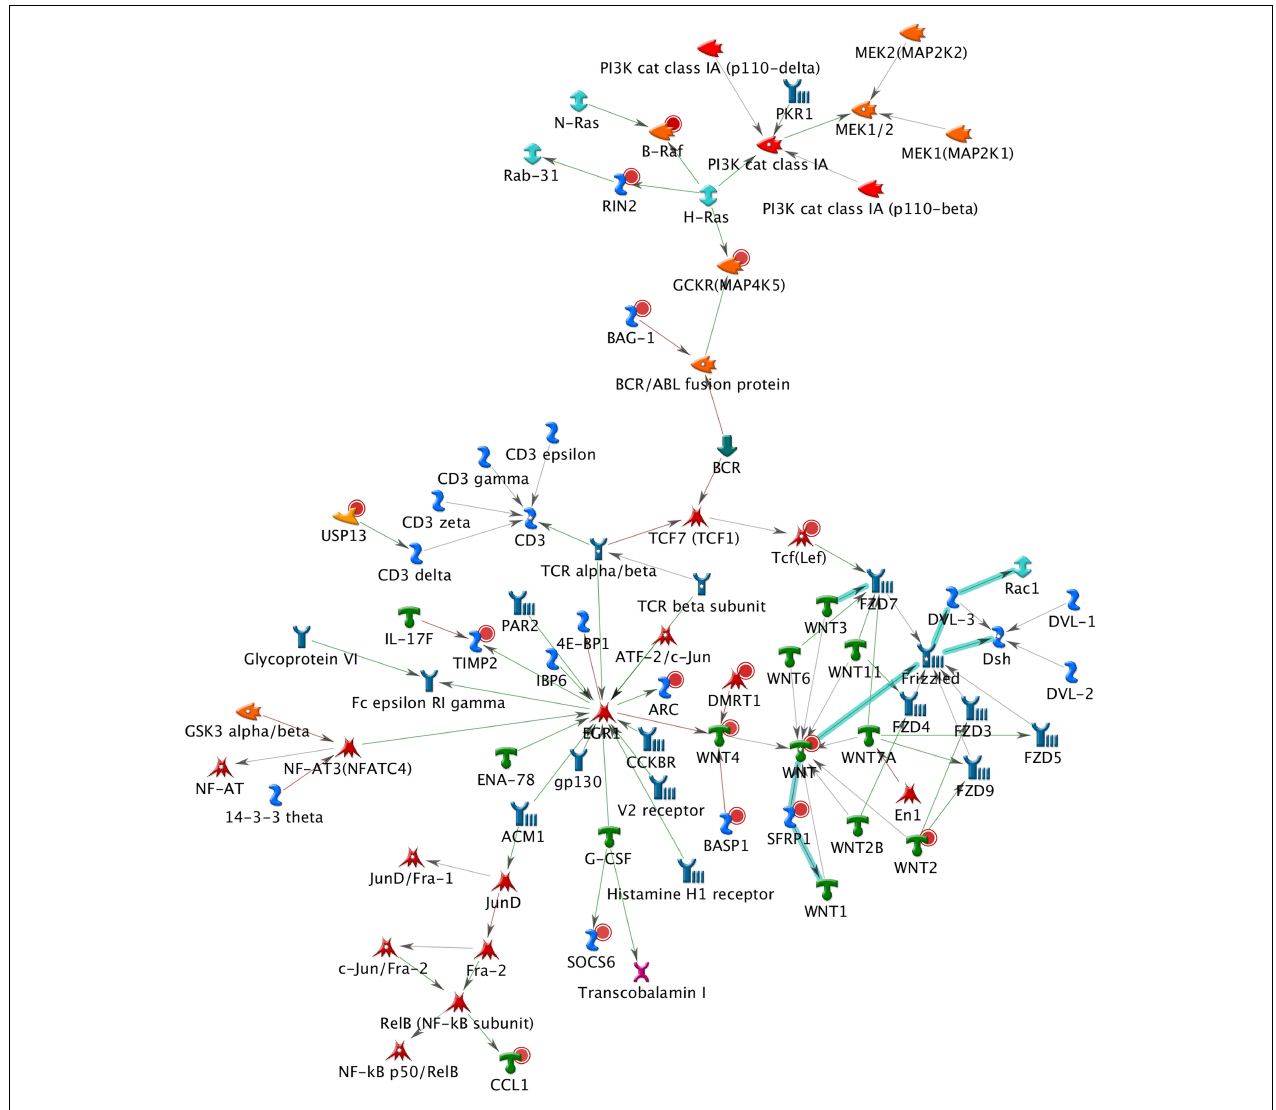
FIGURE 5 | The top three functional subnetwork. This subnetwork contained 16 objects and 64 interactions, with two hubs in a transcription factor (EGR1) and a GPCR receptor (FZD7) with ranging from 5 to 18 interactions. Thick cyan lines indicate the fragments of canonical pathways. Upregulated genes are marked with red circles and downregulated with blue circles. Green and red arrows indicate activation and inhibition effect,